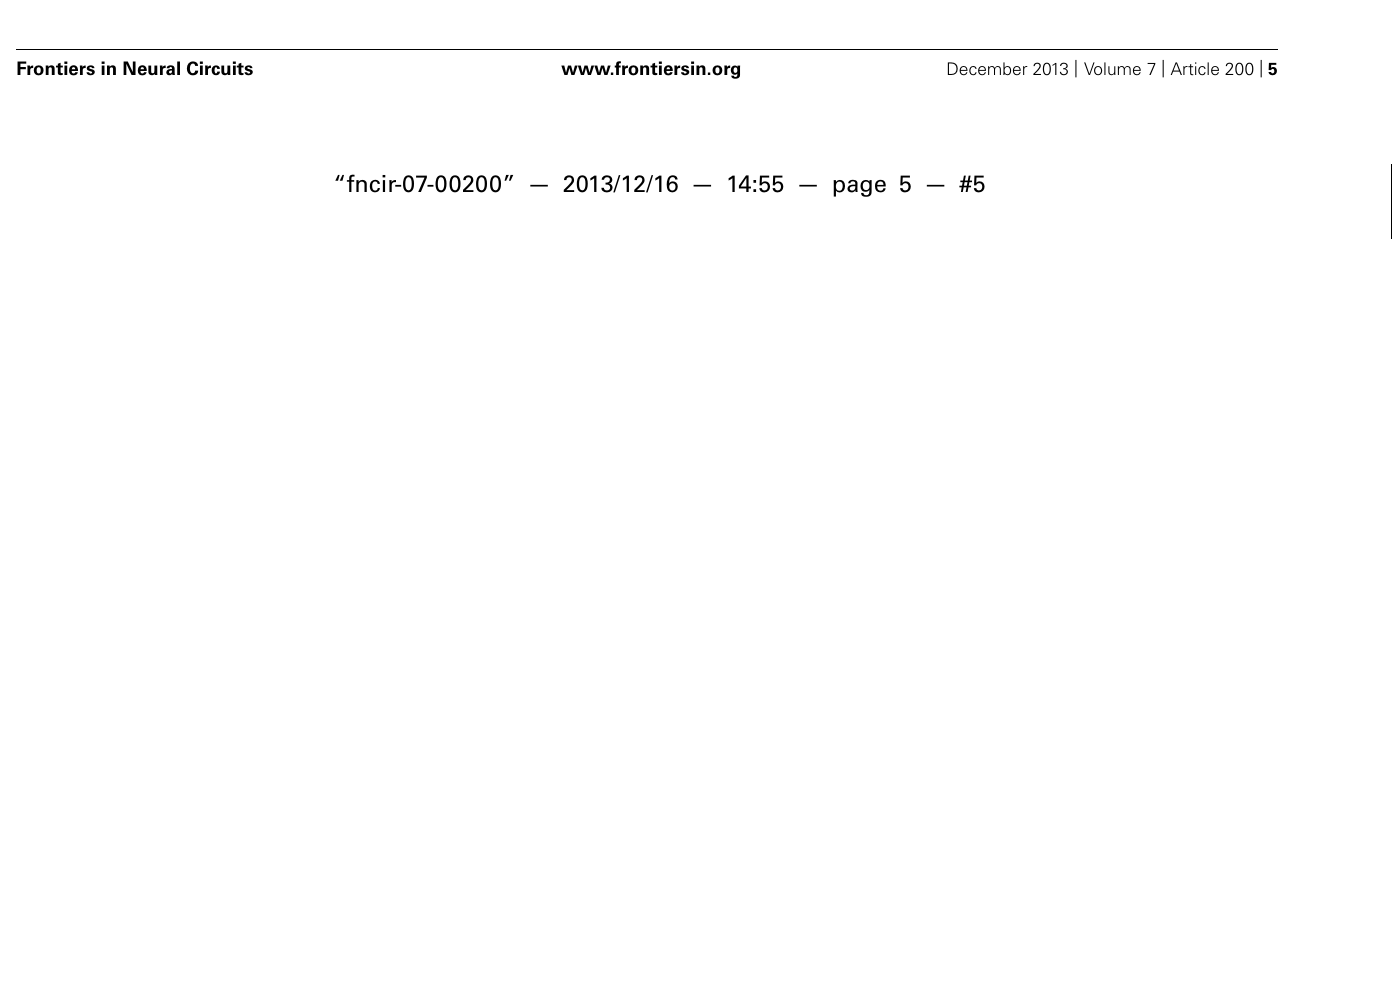
(levels 12–15, gray curve) trials. Arrows indicate the median latencies of the two distributions (0.793 vs. 0.873 s). This subject’s minimum RT (estimated sensorimotor delay) was 0.403 s. (D) Median decision time (DT; reaction time minus sensorimotor delay) for easiest vs. hardest trial types for all N = 12 rats; data for the subject shown in panels (A,C) is highlighted in gray. Symbols above the diagonal identity line ( N = 10/12) indicate a subject that takes more time to respond on harder